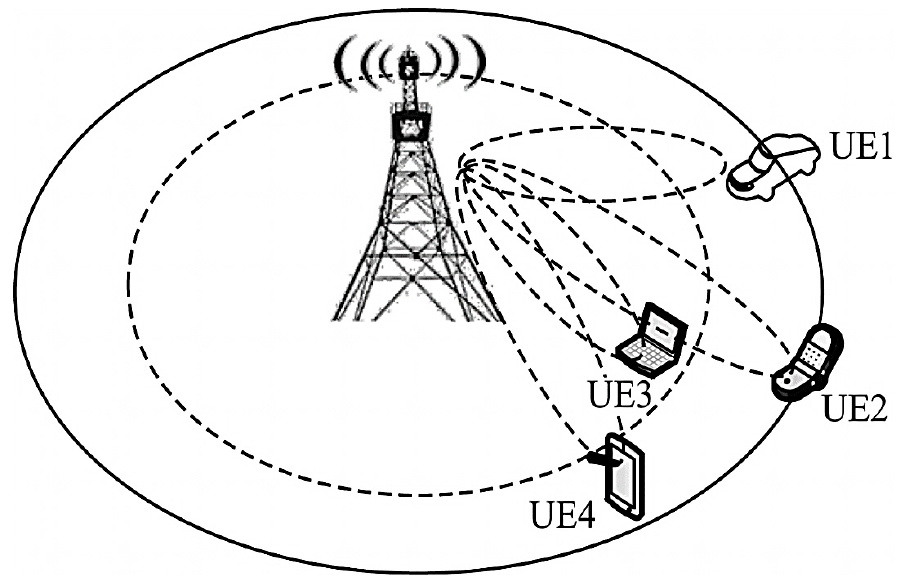
Figure 2. 3D-MIMO antenna beamforming.